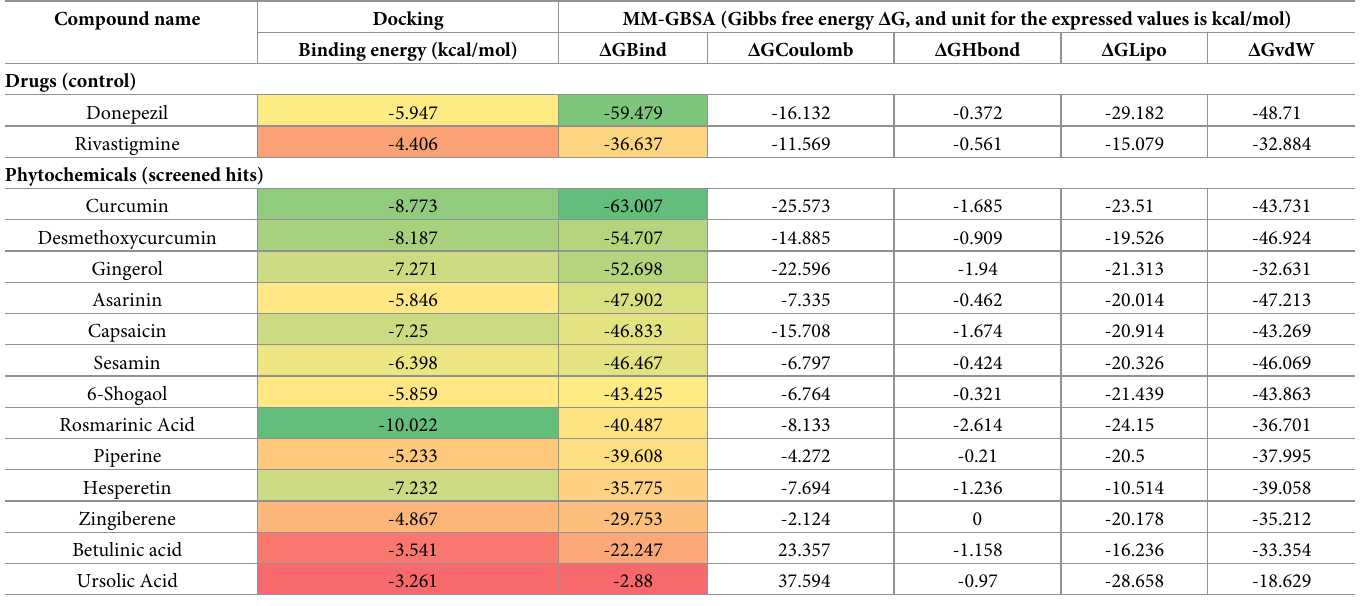
Table 1. Docking and MM-GBSA energy profiles of control drugs and screened phytochemicals during their interaction with